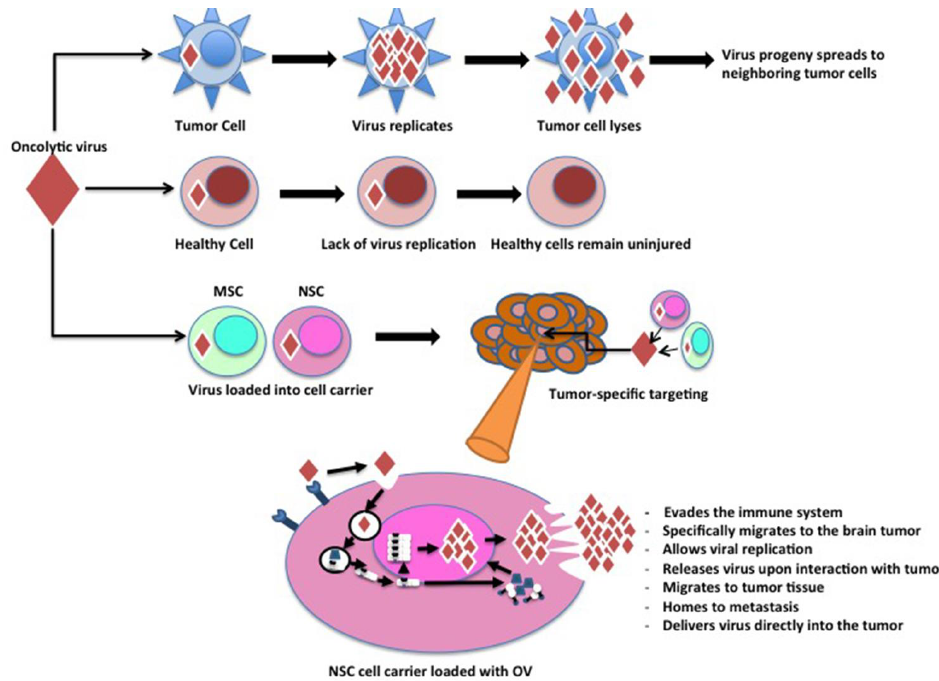
Figure 1. Comparison of modified virus behavior in healthy cells and tumor cells along with mesenchymal stem cells (MSCs) and neural stem cells (NSCs). Virus modification inhibits the ability of virus replication in healthy cells, eliminating the potential of widespread infection upon oncolytic virotherapy injections. However, injected viruses rapidly replicate in tumor cells, causing lysis of tumor cells. This allows the virus to destroy malignant cells and spread throughout the tumor population.